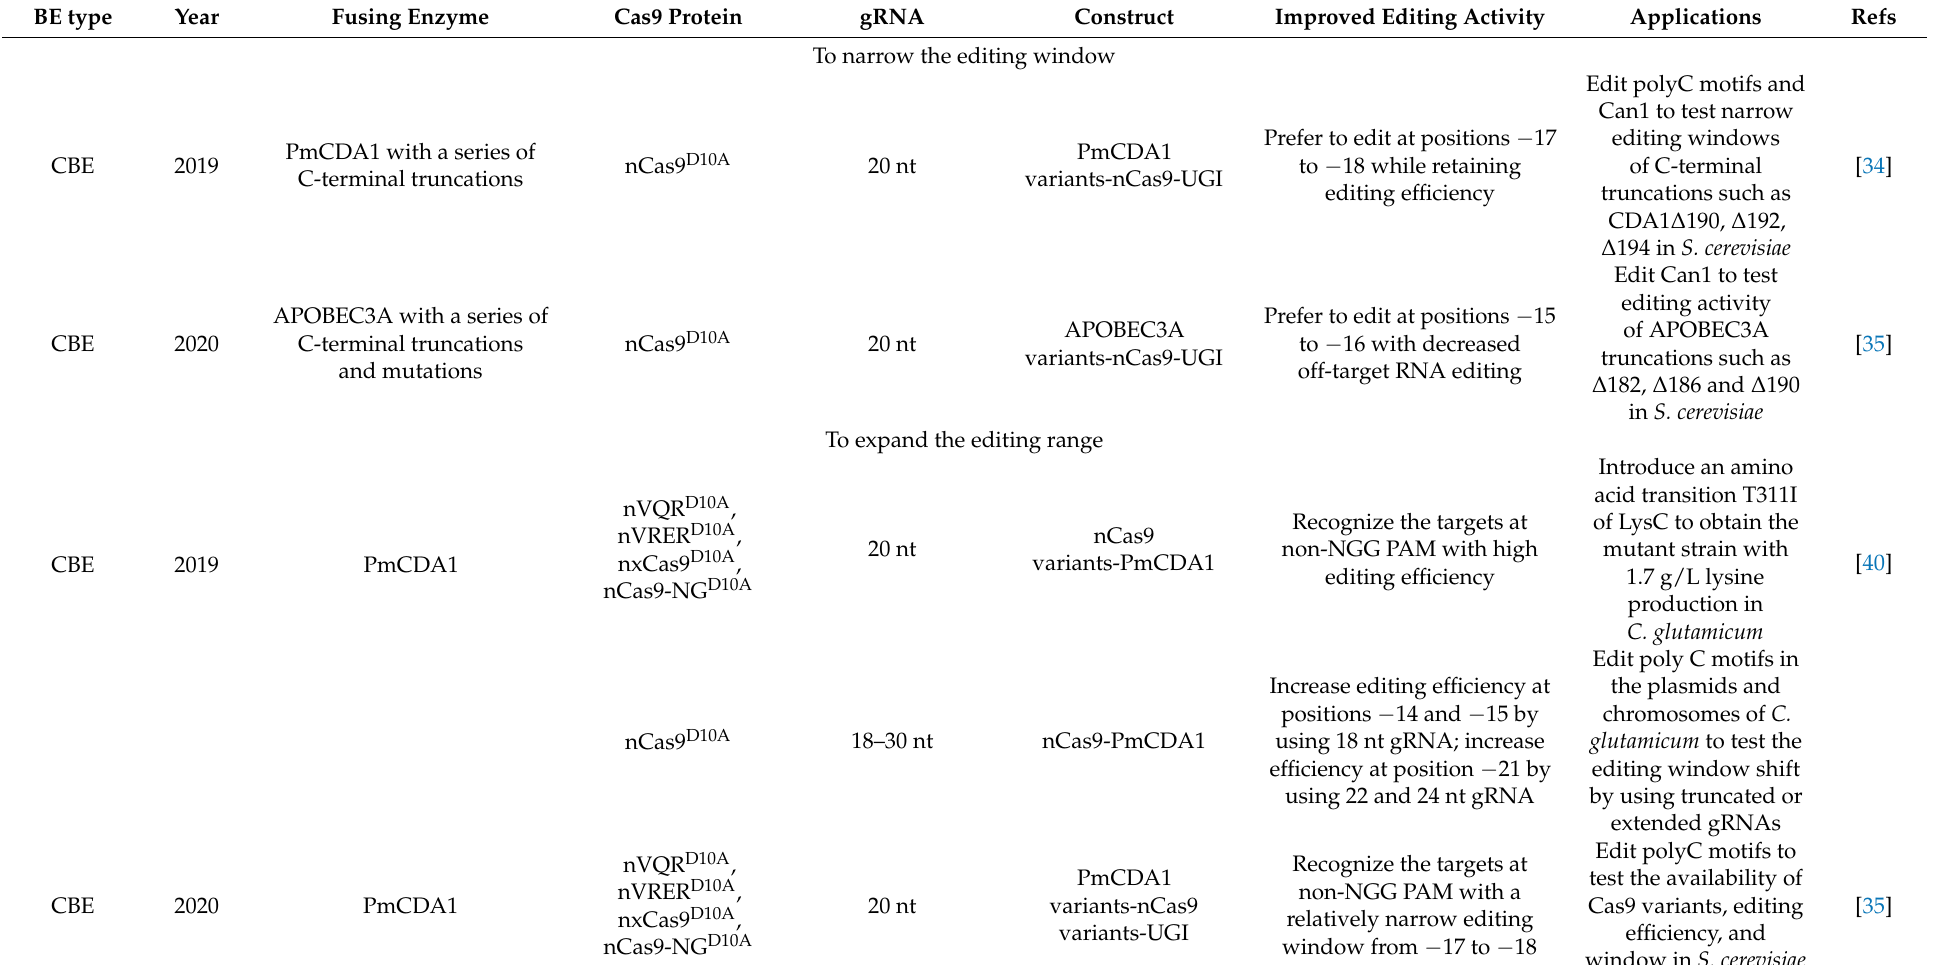
Table 1. Developed Versions of BEs to Overcome Editing Limitations in